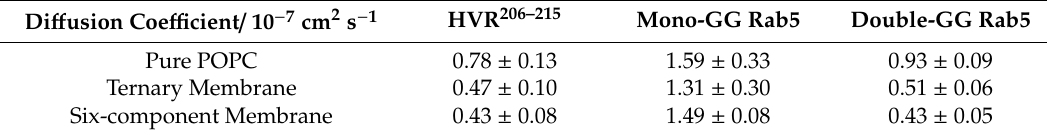
Table 2. Lateral di ff usion coe ffi cients of the geranylgeranyl (GG) anchor in di ff erent membranes.